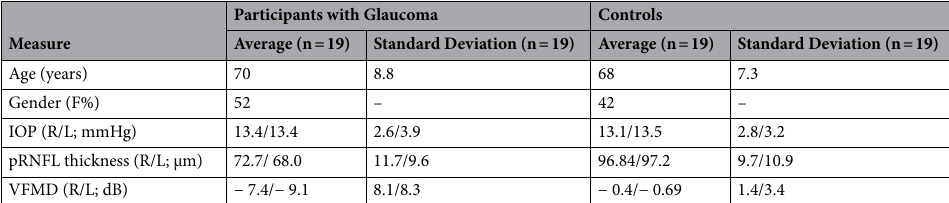
Table 1. Demographics of participants with glaucoma and controls. Average and standard deviation of age, percentage of female, intraocular pressure (IOP) for the right and left eye (average over three measurements), peripapillary retinal nerve fiber layer (pRNFL) thickness and the VF mean deviation (VFMD) measured with SAP for the right and left eye. Note that participants with glaucoma were receiving